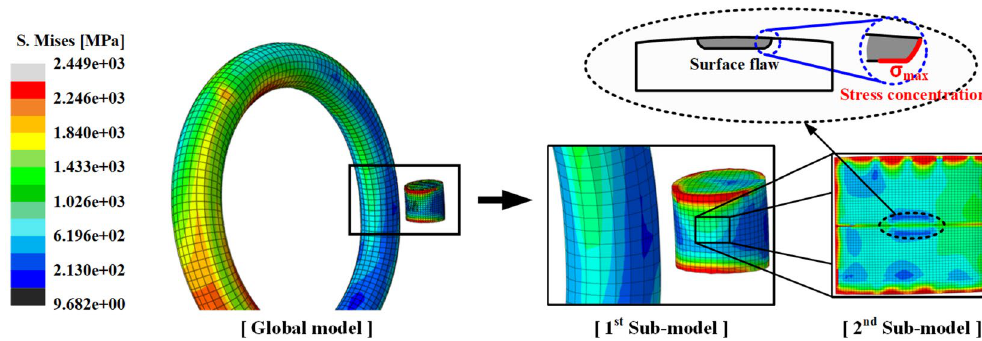
Figure 12. Effective stress distribution during the cold coiling